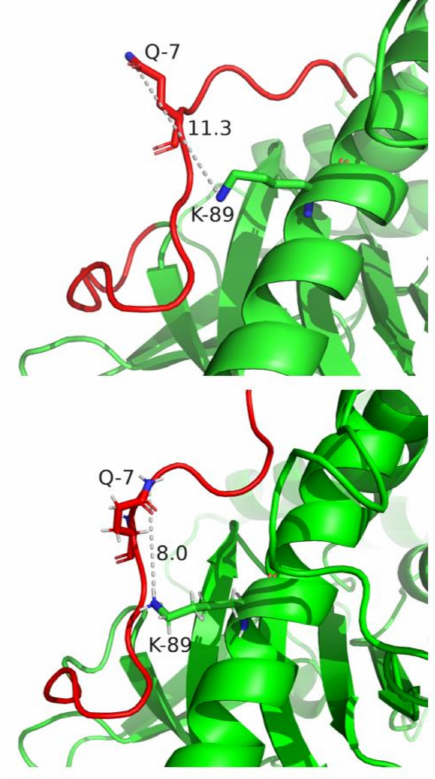
Figure 6. Structures of the proposed A1 and A3(LM) intramolecular interactions. ( Top ) Crystal structure of A1 (PDB:1XTG) and ( Bottom ) A3LM (PDB:7DVL) distance between glutamine (Q 7 ) and lysine (K 89 ) as measured with PyMOL. The N of A1 and A3LM is highlighted in red with the remaining regions of LC in